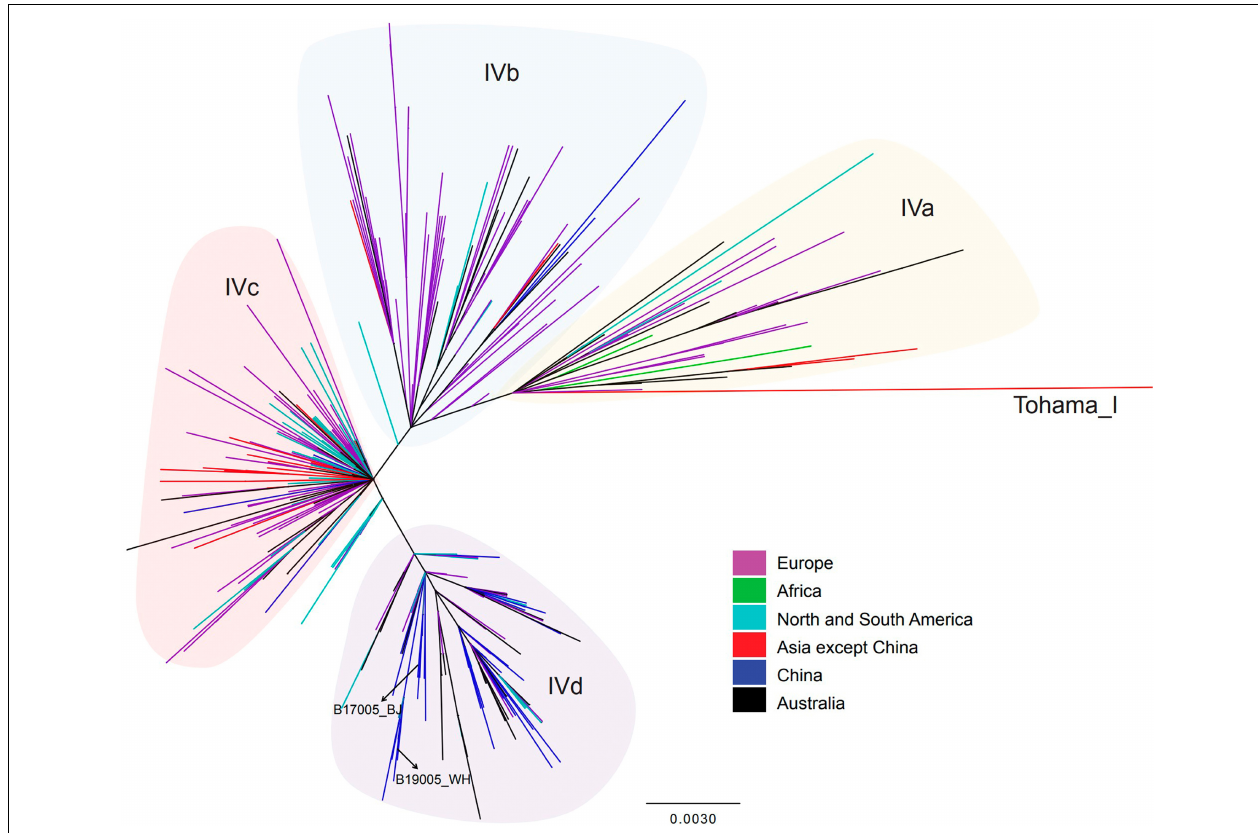
FIGURE 4 | Single-nucleotide polymorphisms-based phylogenetic tree for lineage IV B. pertussis strains isolated from China and other countries. Maximum-likelihood phylogenetic tree of 358 B. pertussis isolates from China (8 isolates from the present study and 46 from the previous study) and other countries (304 isolates), based on whole-genome SNPs. According to the legend, the branch colors indicate the isolate resource (country). Shadow colors indicate lineages. Basic information regarding the strains included in this figure is presented in Supplementary Table 2